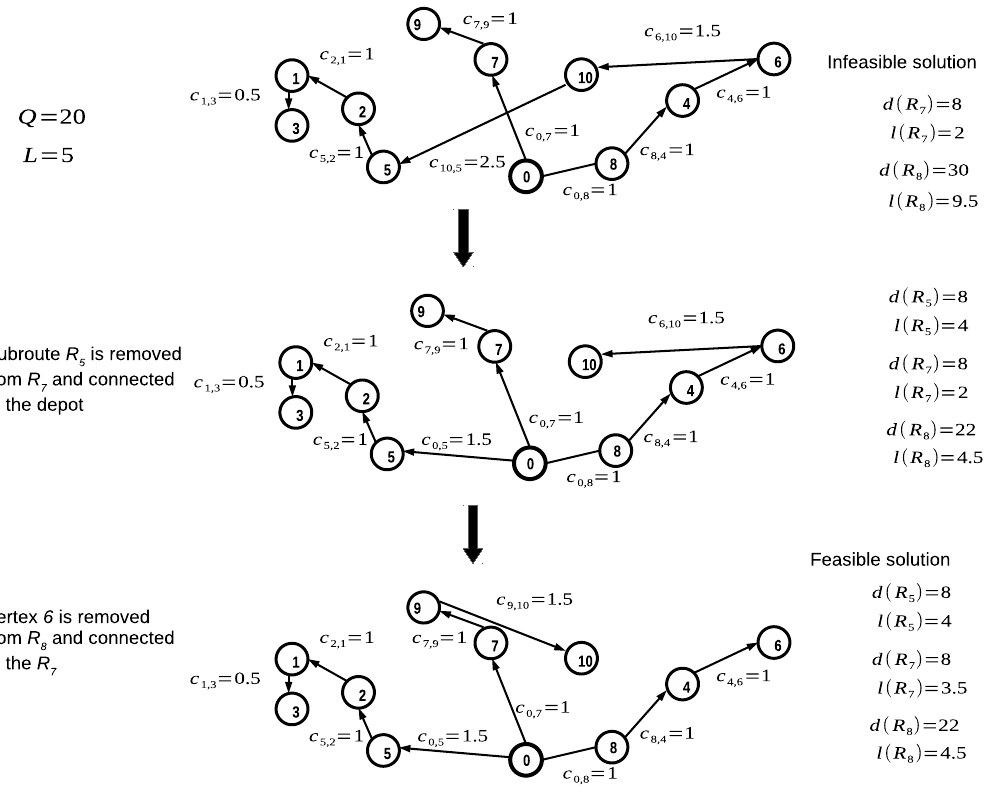
Figure 4. Feasibility recovery procedure example of an infeasible solution.